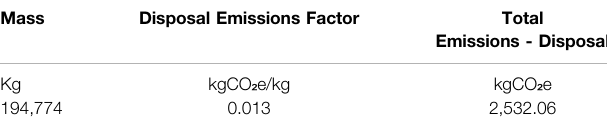
TABLE 10 | Disposal emissions.